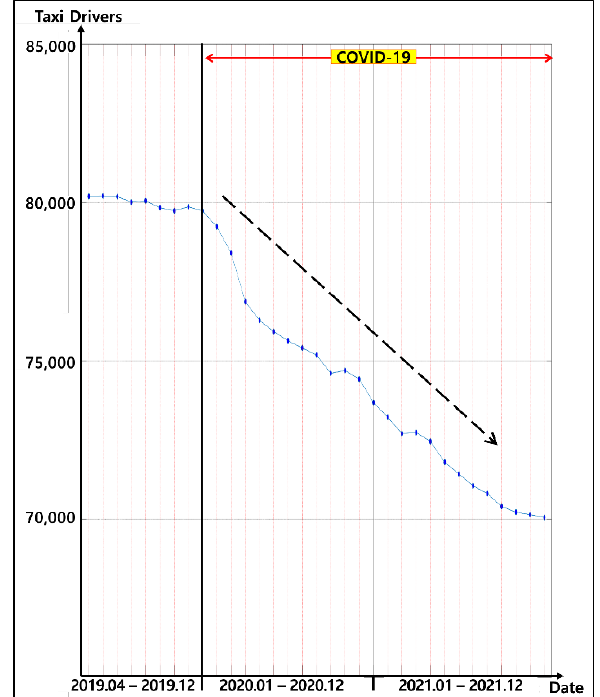
Figure 3 . Number of Taxi Drivers in Seoul (2019.04 - 2020.12)